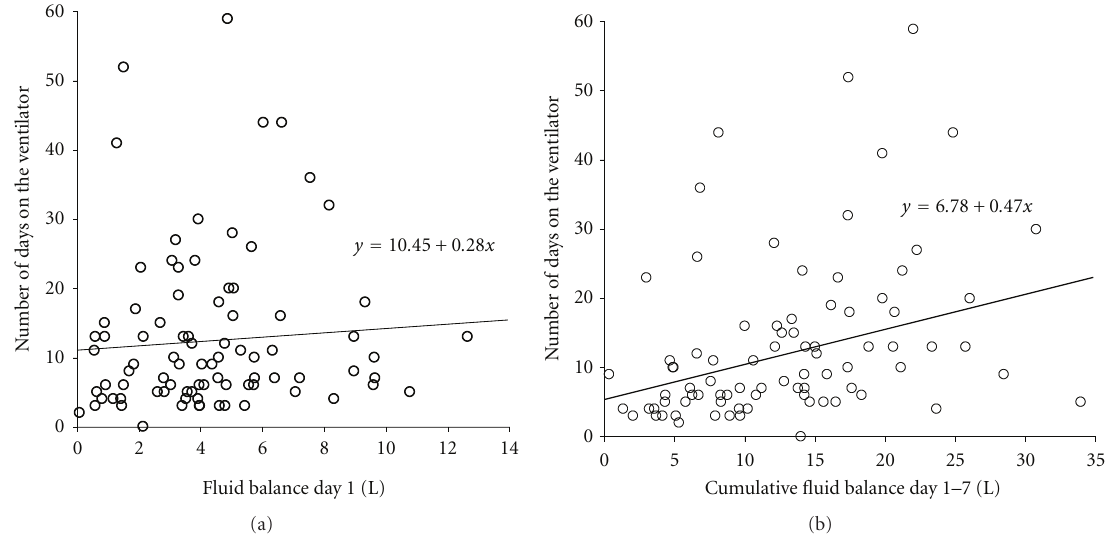
Figure 3: Linear regression analysis on the relation between the total number of days on the ventilator and the fluid balance after 24 hours (a), as well as the fluid balance after 7 days